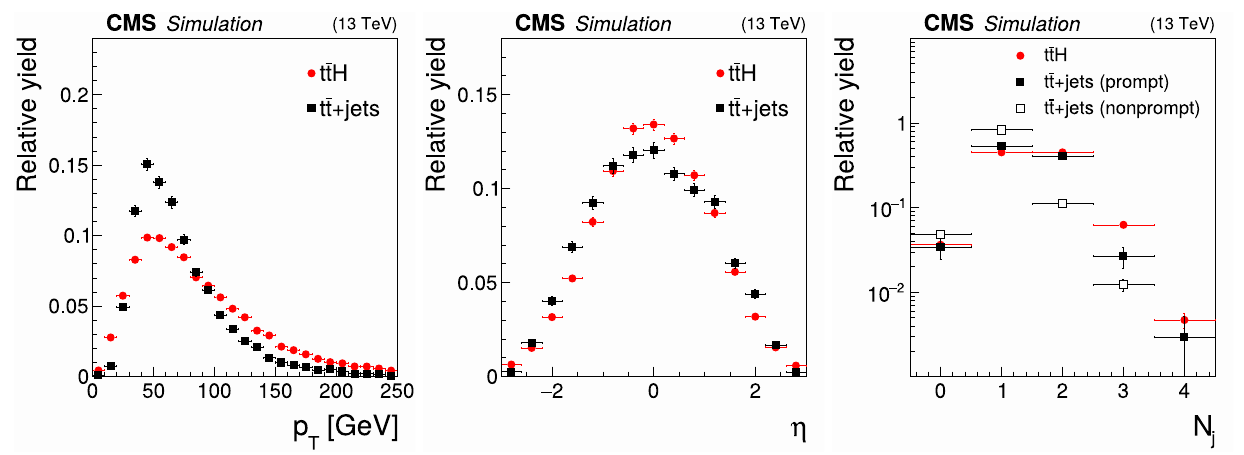
Fig. 4 Transverse momentum (left) and pseudorapidity (middle) dis- tributions of bottom quarks produced in top quark decays in ttH signal events compared to tt+jets background events, and multiplicity of jets passing tight b jet identification criteria (right). The latter distribution is